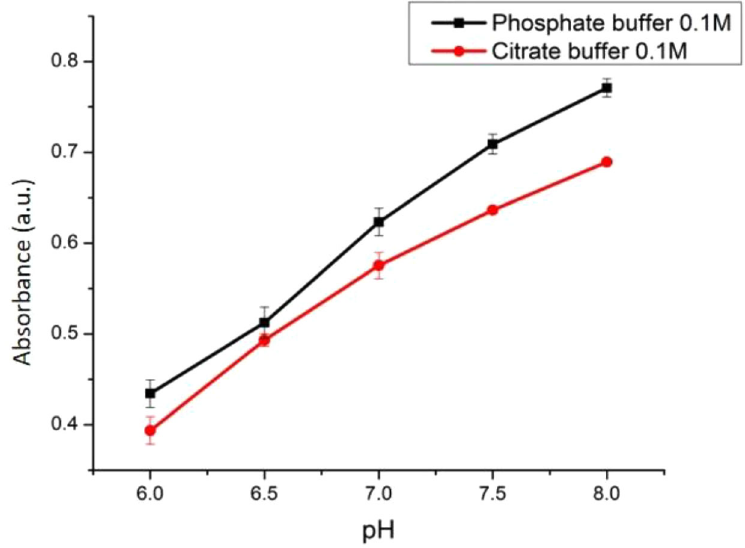
Figure 10. Effect of buffer type towards the sensitivity of optical pH sensor.